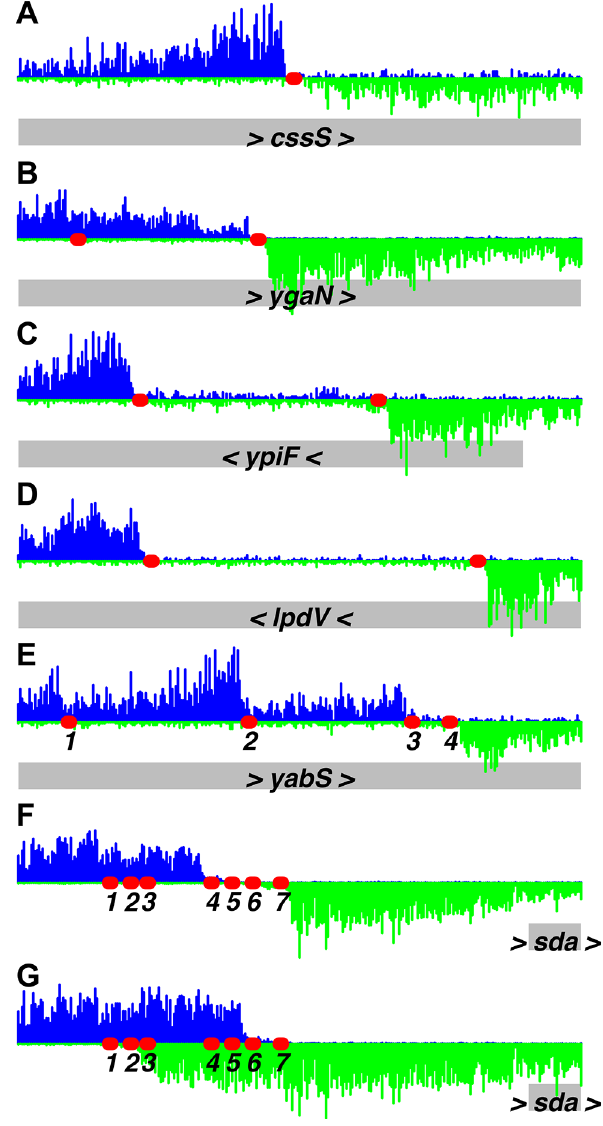
Fig 3. Identification of DnaA binding sites at single nucleotide resolution. Histograms of the number of sequence reads that start at each nucleotide are plotted as in Fig 2 (blue, above the line, for sequence reads mapping to the top strand; green, below the line, for sequence reads mapping to the bottom strand). Data are from a binding reaction containing 4.1 μ M ATP-DnaA-his, except for panel F , where data are from a reaction containing 55 nM ATP-DnaA-his. For each panel, a 300 bp portion of the genome is presented, and the y-axis is scaled so that the data fills the space. Predicted DnaA boxes are represented by red ovals, and are numbered from left to right for regions with more than three DnaA boxes. The gray rectangles below the histograms depict nearby genes, with arrowheads indicating the direction of transcription. The regions presented are: (A) inside cssS ; (B) inside ygaN ; (C) inside ypiF ; (D) inside lpdV ; (E) inside yabS ; (F) upstream of sda (55 nM ATP-DnaA-his data); (G) upstream of sda (4.1 μ M ATP-DnaA-his data). Panel B corresponds to peak #140 (S1 Table and S1 Fig) and panels F and G correspond to peak #7. The other regions did not show sufficient binding at 1.4 μ M DnaA to be included in the peak